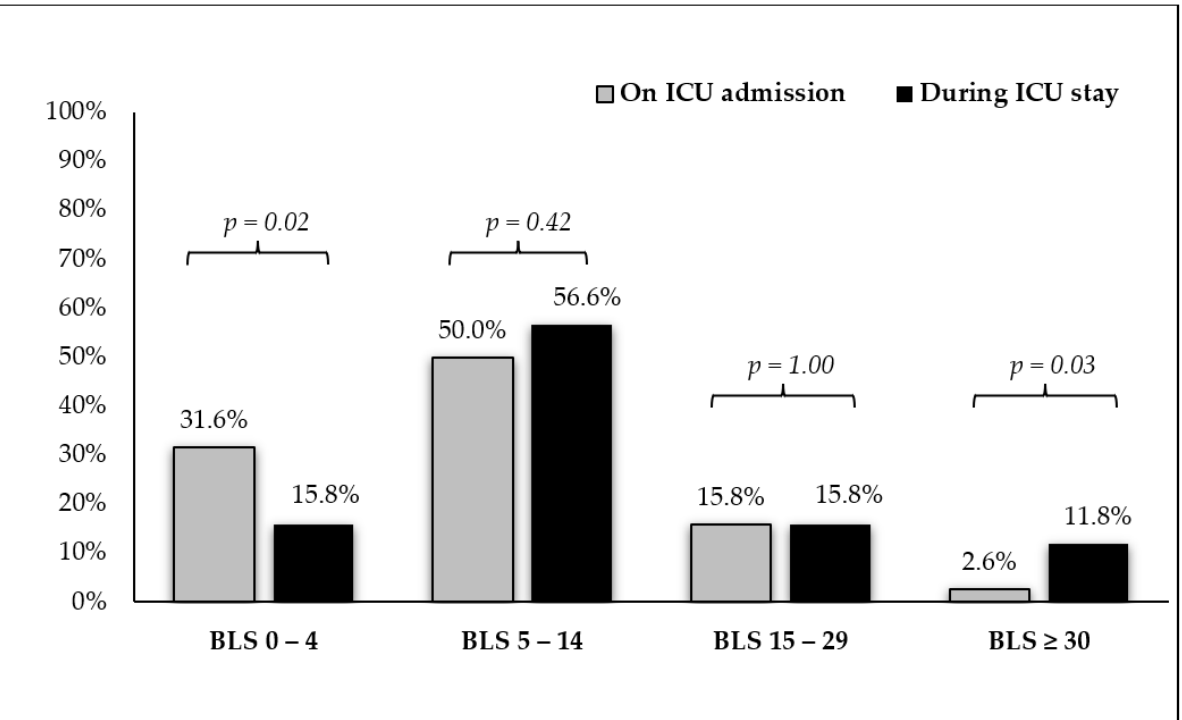
Figure 4. B-Line score dynamics in the active group. The figure shows the percentages of patients with no (BLS = 0–4), mild (BLS = 5–14), moderate (BLS = 15–29), and severe (BLS ≥ 30) EVLW increase on ICU admission and during ICU stay.